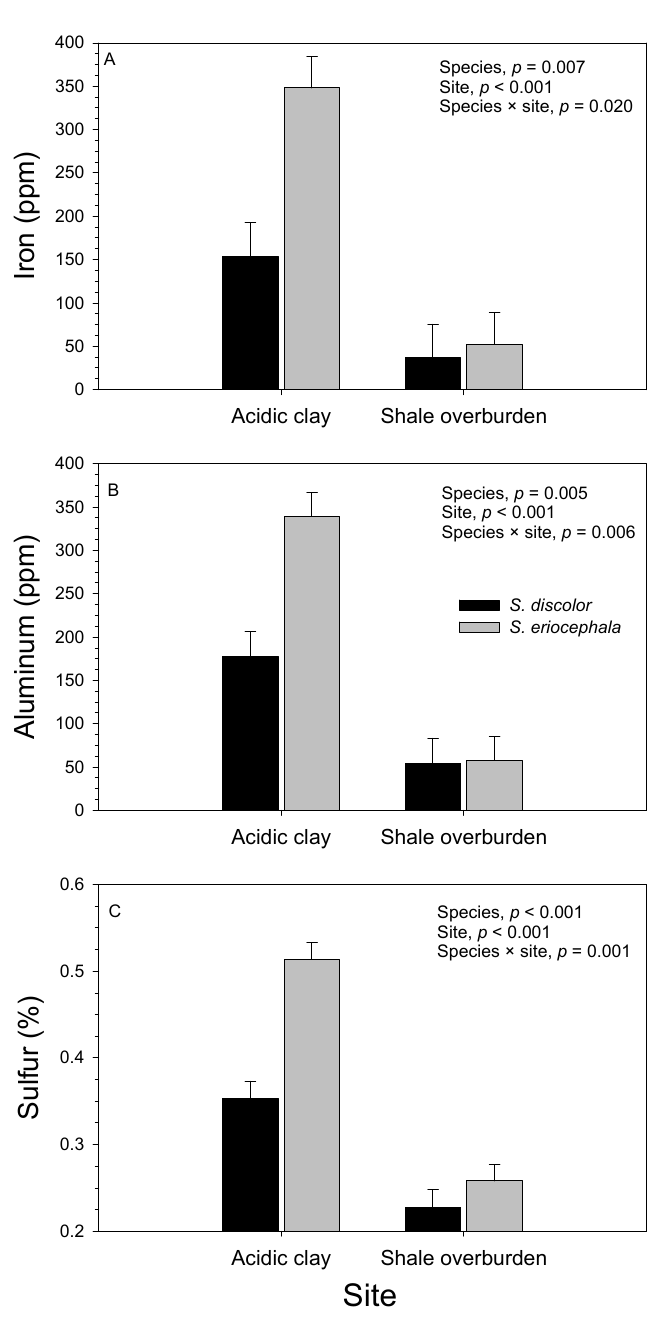
Figure 5. Foliar ( a ) iron, ( b ) aluminum and ( c ) sulfur concentrations (mean ± SE) of Salix discolor